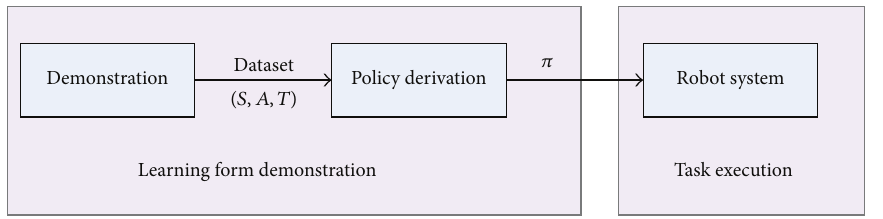
Figure 1: Framework of learning form demonstration